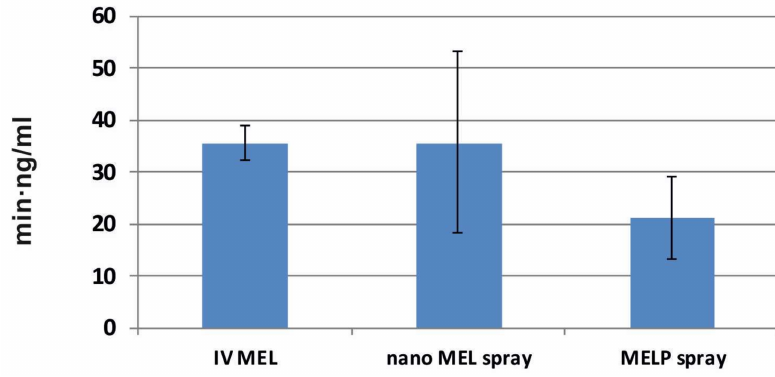
Figure 7. AUC values in the brain tissues of IV MEL and sprays contain nano MEL and